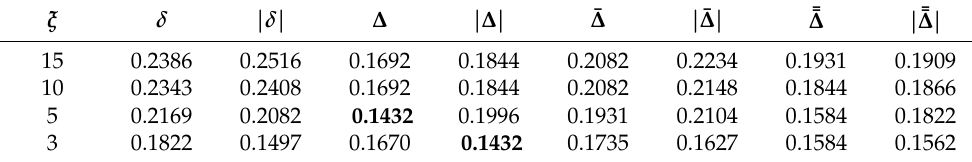
Table 7. Classification loss for observations not used for training ( w h = 1, w g = 1.5).